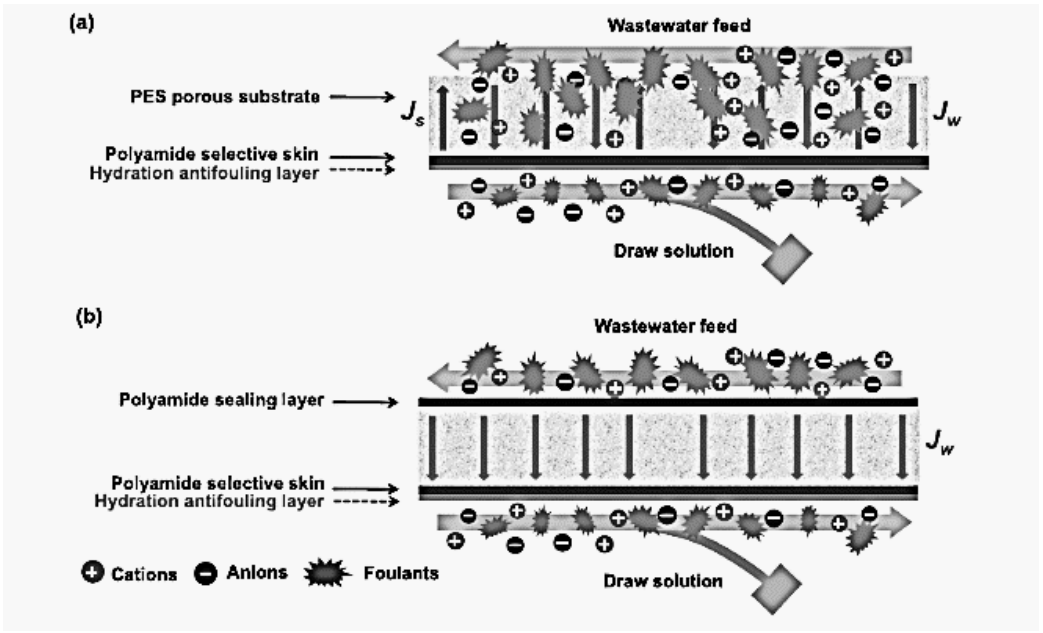
Figure 7. Schematic of fouling phenomena: ( a ) The conventional thin-film composite (TFC) membrane and ( b ) the newly developed double-skin TFC membrane in forward osmosis (FO) (under the pressure-retarded osmosis (PRO) mode) and PRO processes [30].